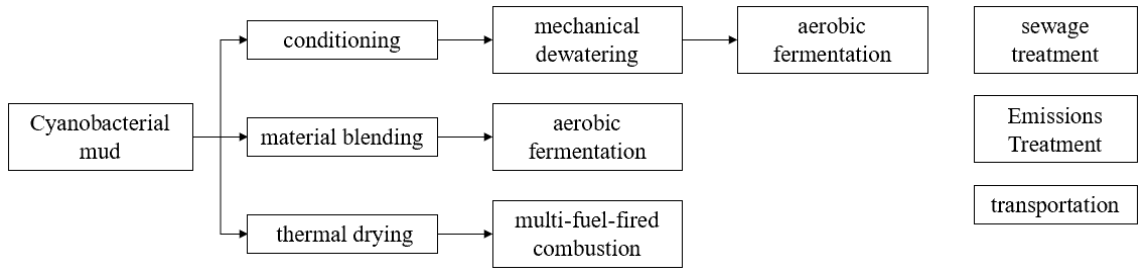
Figure 1. The brief process flowchart and the main carbon emission units.